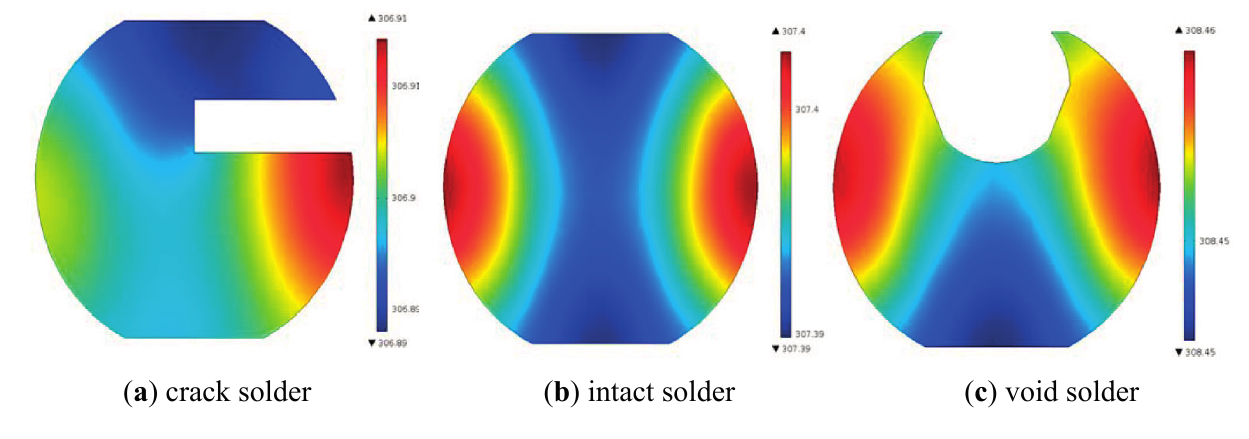
Figure 2. Profile temperature